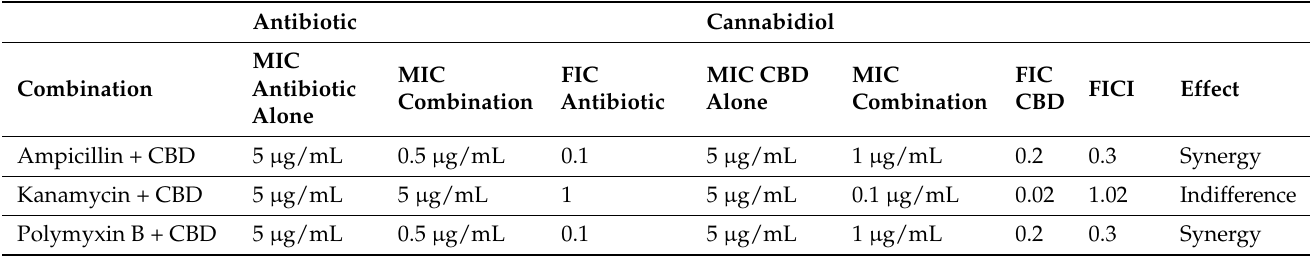
Figure 5. Synergistic activity of CBD and Antibiotics (Ampicillin (AMP), Kanamycin (KAN), Polymyxin-B (POLY-B)) against S. typhimurium . Isobologram showing the synergy (FICI < 0.5), partial synergy (0.5 ≤ FICI ≥ 0.75), additive (0.76 ≤ FICI ≥ 1), indifference (1 ≤ FICI ≥ 4), or antagonism (FICI > 4) effects of CBD paired with broad-spectrum antibiotics against S. typhimurium . Representative data for determination of FICI is included. Table 1. Final Inhibitory Concentration Index (FICI) calculations for Ampicillin-CBD, Kanamycin- CBD, and Polymyxin B-CBD co-treatments. Effect of co-treatments described as synergy (FICI < 0.5), partial synergy (0.5 ≤ FICI ≥ 0.75), additive (0.76 ≤ FICI ≥ 1), indifference (1 ≤ FICI ≥ 4), or antagonism (FICI > 4).